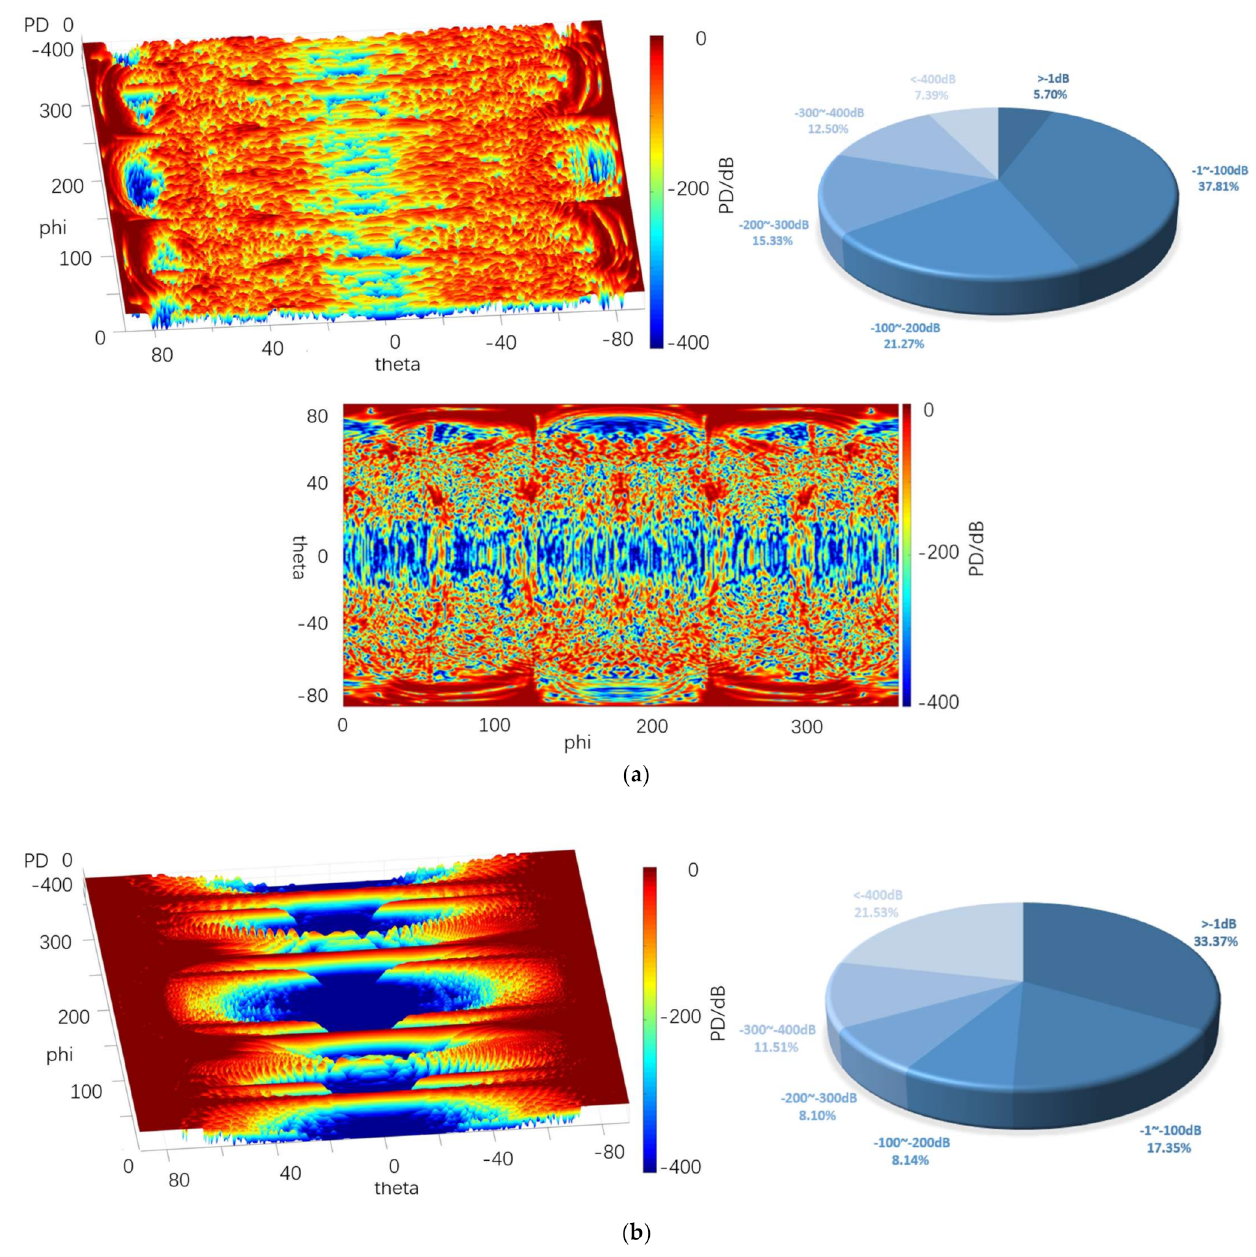
Figure 21. Probability distribution in the 4 π direction for 1400 km. ( a ) Quantum detection probability, ( b ) Probability of conventional